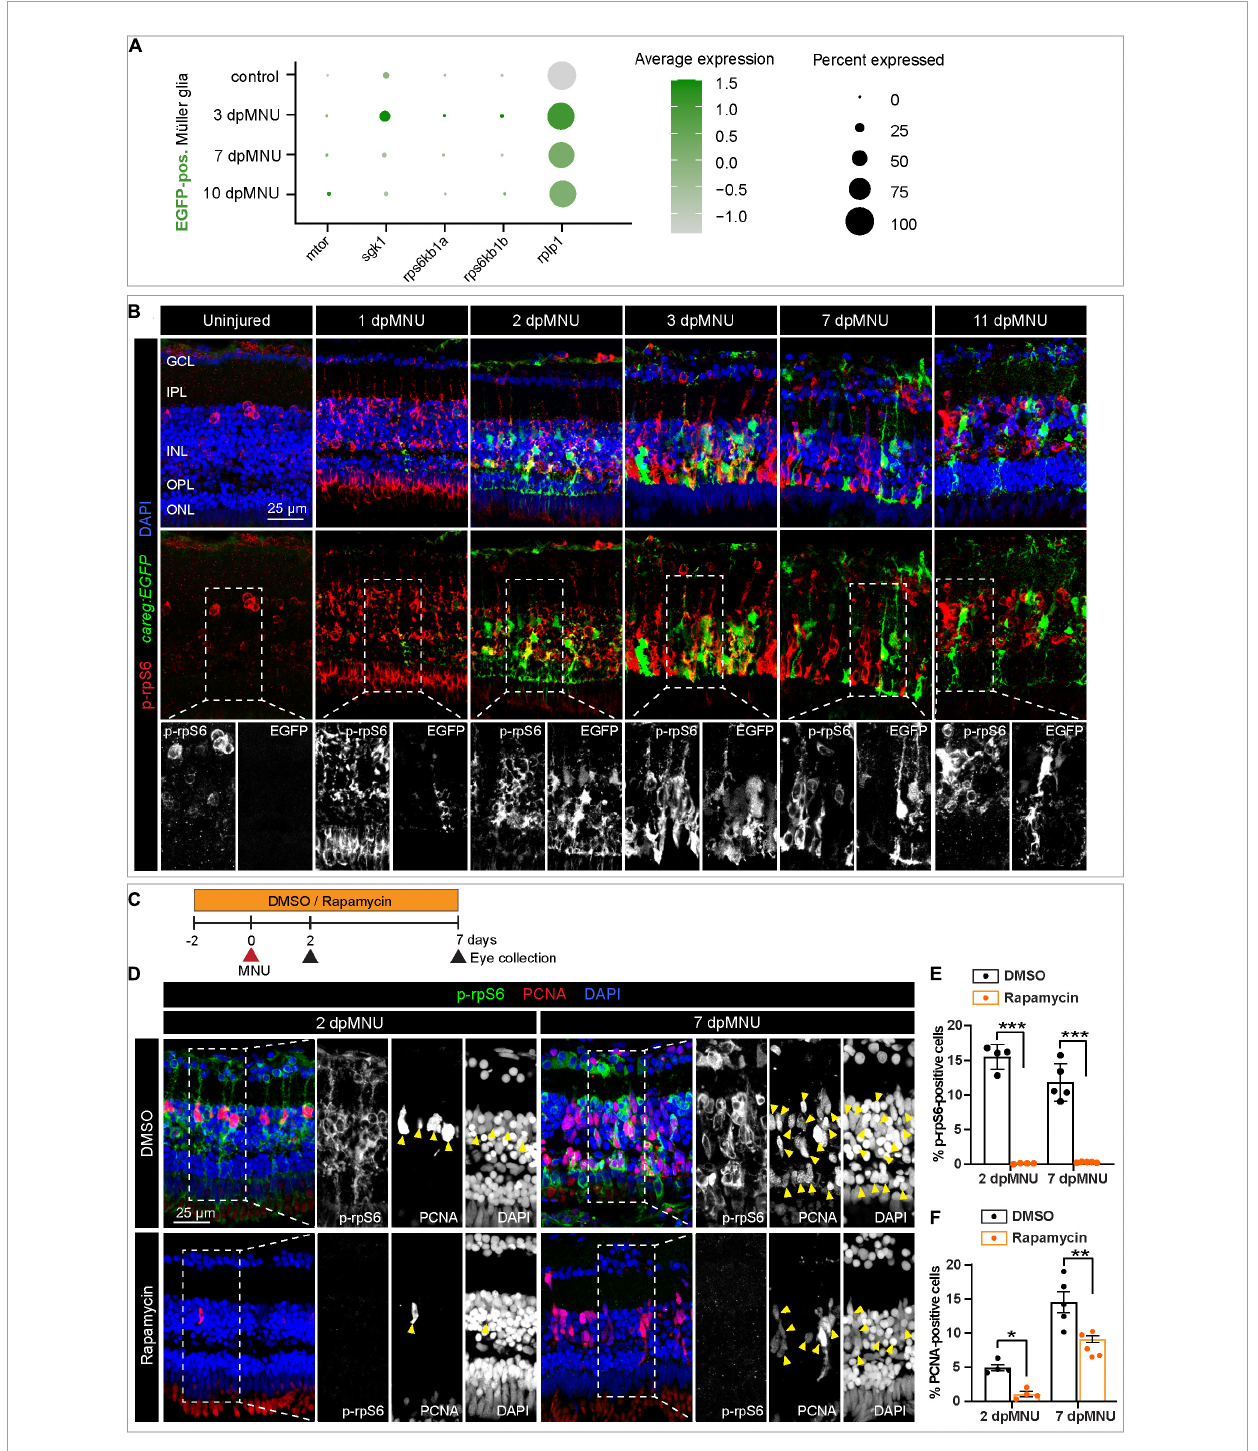
FIGURE9 The careg element is transiently associated with phospho-rpS6-immunoreactive cells in regenerating retina. (A) Dot plot displaying differential expression levels of mtor and its downstream signaling components encoding ribosomal proteins in careg:EGFP -positive and careg:EGFP -negative Müller glia at different conditions. (B) careg:EGFP retina sections at different time-points post-MNU-treatment immunostained against phospho-ribosomal protein S6 (p-rpS6, red) and DAPI (blue). In uninjured retina, a few p-rpS6-positive cells (red) are detected in the inner nuclear layer (INL). At 1 dpMNU, a massive increase of p-rpS6 occurs across the INL. At 2 and 3 dpMNU, a colocalization between p-rpS6 (red) and careg:EGFP (green) is observed. At 7 and 11 dpMNU, most of cells are single-positive for each of these markers. (C) Workflow with 0.1% DMSO and 1 µ M Rapamycin treatment. (D) Retina sections at 2 and 7 dpMNU treated with DMSO or Rapamycin immunostained for p-rpS6 (green), PCNA (red), and DAPI (blue). In control samples, PCNA-positive cells are also p-rpS6-positive (arrowheads). Rapamycin treatment abrogates p-rpS6 expression and reduced the number of PCNA-positive cells. (E,F) Quantification of PCNA-positive and p-rpS6-positive cells. Histogram displays average values for each group. Each dot represents a biological replicate ( N > 4). Error bars, SEM. P -value was determined by two-way ANOVA with Šidák multiple comparisons test. * P = 0.034; ** P = 0.0017; *** P <